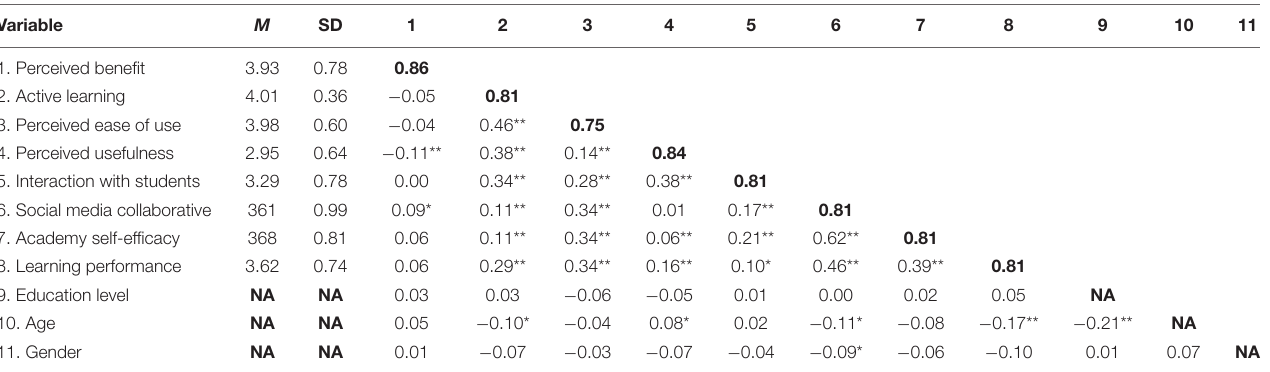
TABLE 3 | Comparison measure model and structural model.